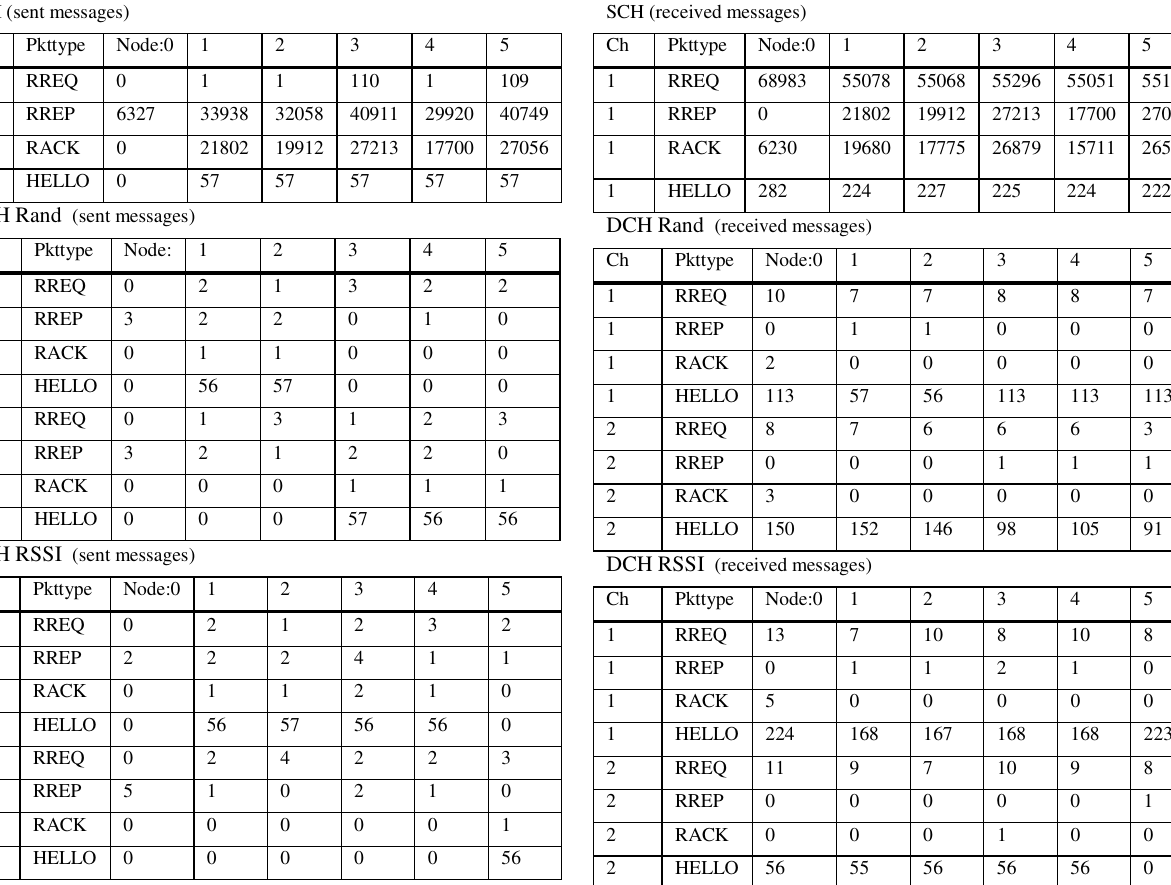
Table 2: Count of AODV control messages sent from a node to all other nodes for SCH, DCH Rand and DCH RSSI AODV.